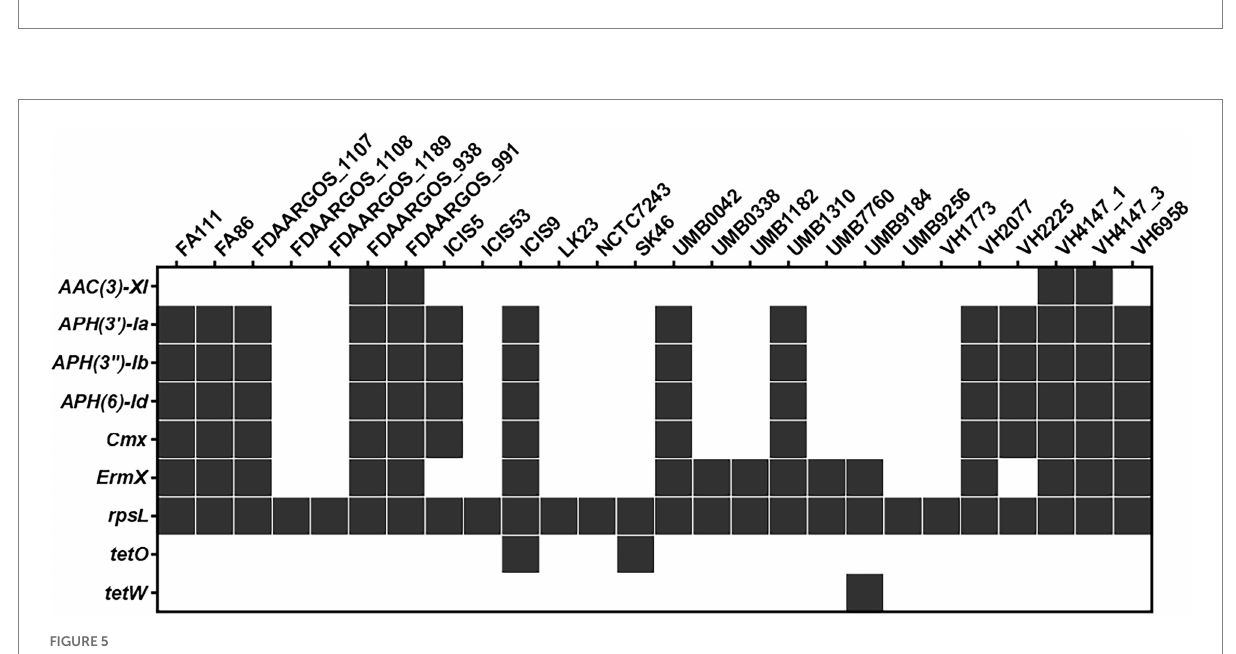
FIGURE 5 The C. amycolatum resistome predicted through automated annotation in the PATRIC